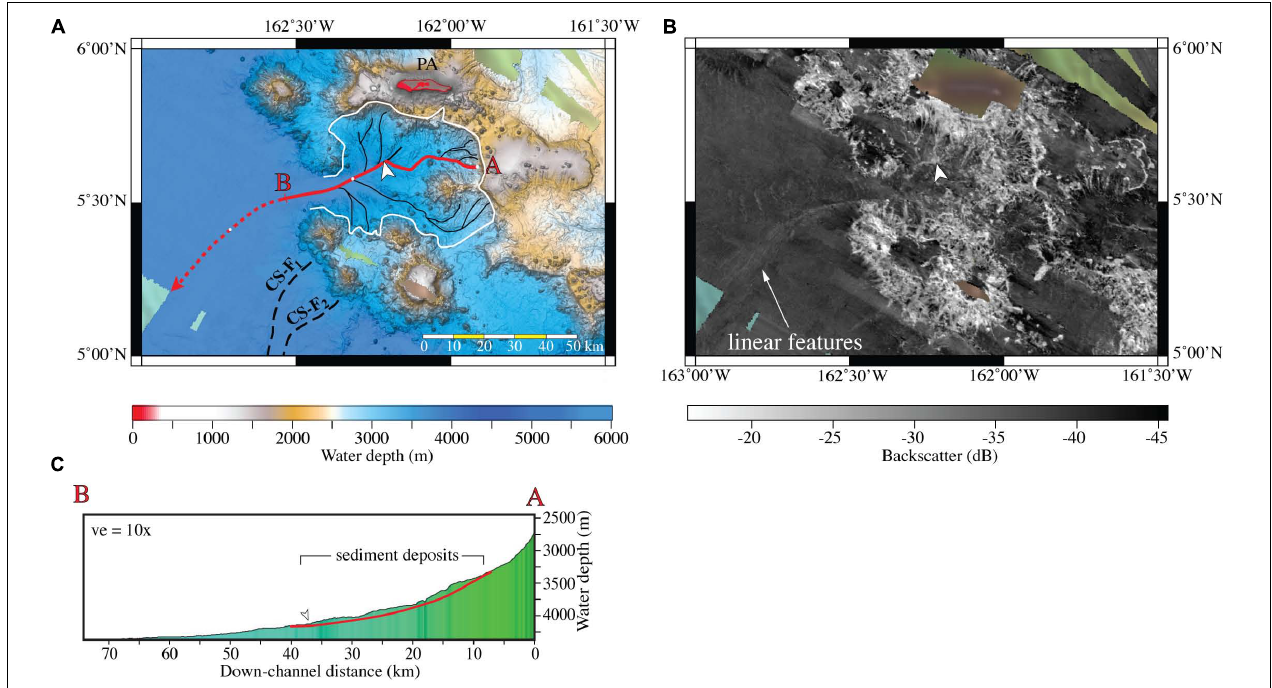
FIGURE 10 | Map view of multibeam bathymetry (A) and acoustic backscatter (B) of channel system CS-C (see Supplementary Figure S7 for same view with no interpretations). Location of CS-C shown on Figure 3 . Drainage area (see text) outlined in white, main channel in red with red dashed line showing probable path of main channel and tributaries in black. Linear features labeled in (B) are discussed in text. (C) Down channel profile of main channel A–B. White arrowhead points to location of a 62-m-high hanging valley where the upper main channel has captured a small first-order tributary. Note sediment deposits above the idealized concave-up curvature (red line in profile A–B) of the main